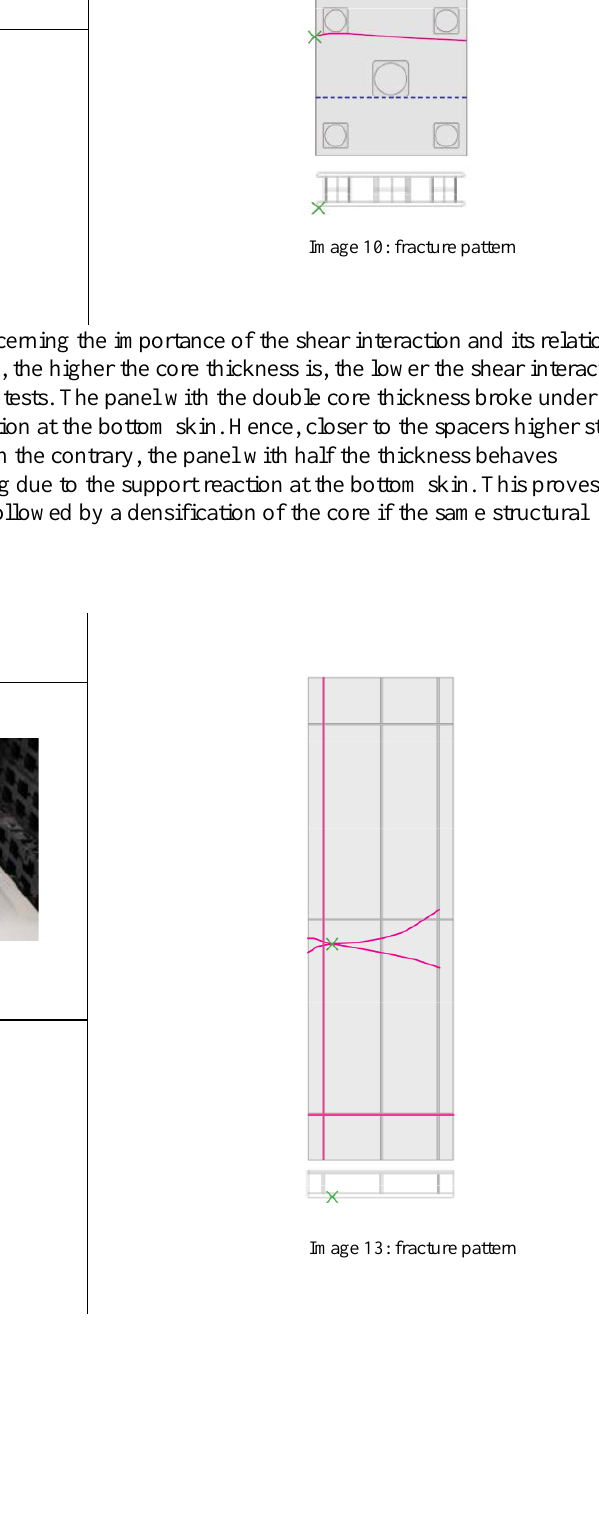
Image 11: photo of the core of panel 4